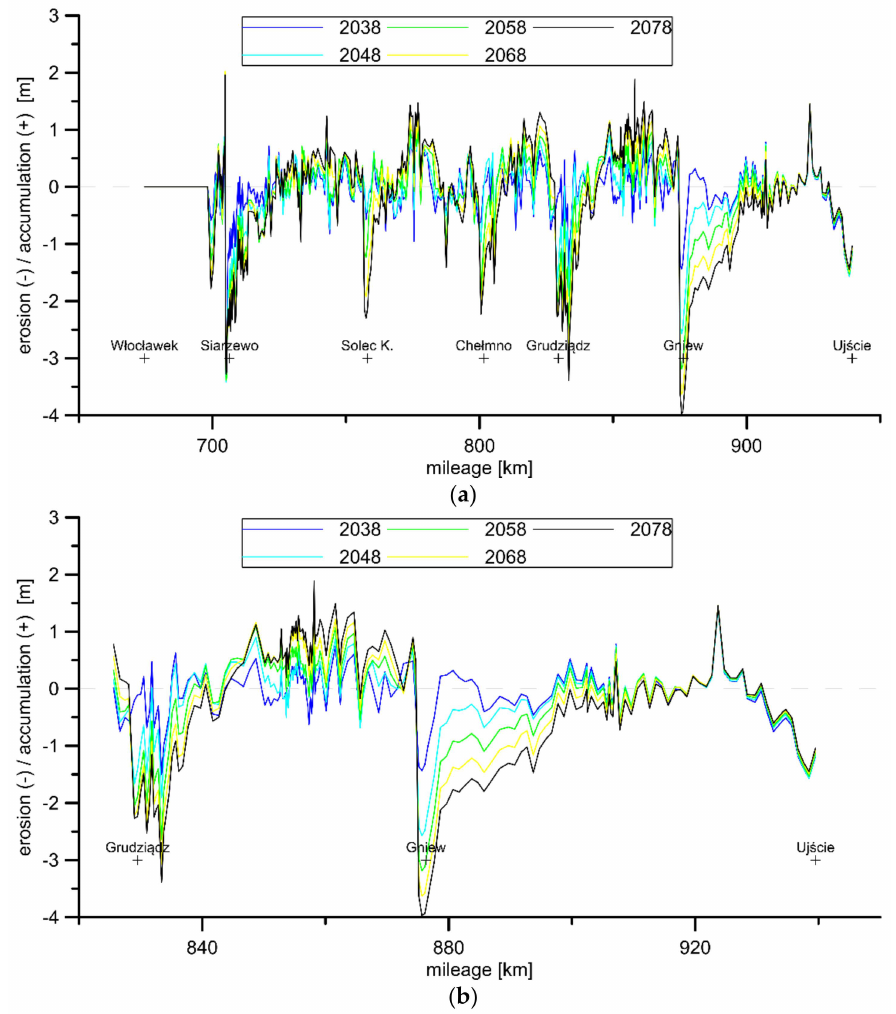
Figure 6. ( a ). The difference between the bathymetry calculated in the SII scenario and the initial bathymetry. ( b ). The difference between the bathymetry calculated in the SII scenario and the initial bathymetry for the lower part of the analyzed river